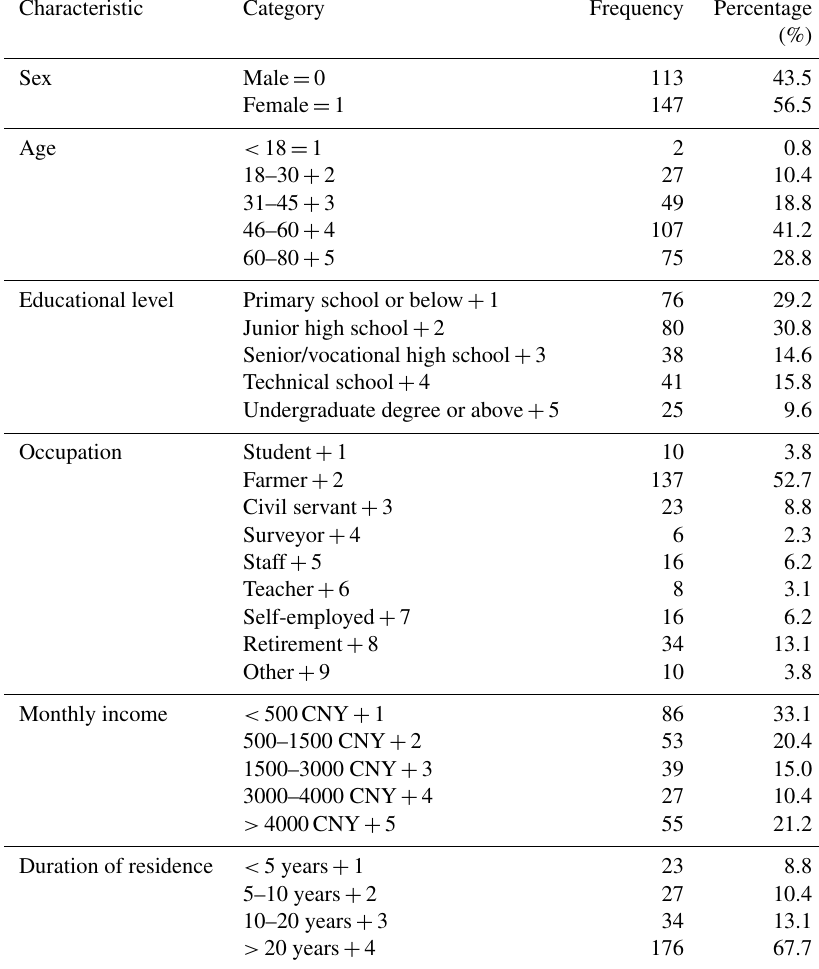
Table 2. Demographic characteristics of the respondents.